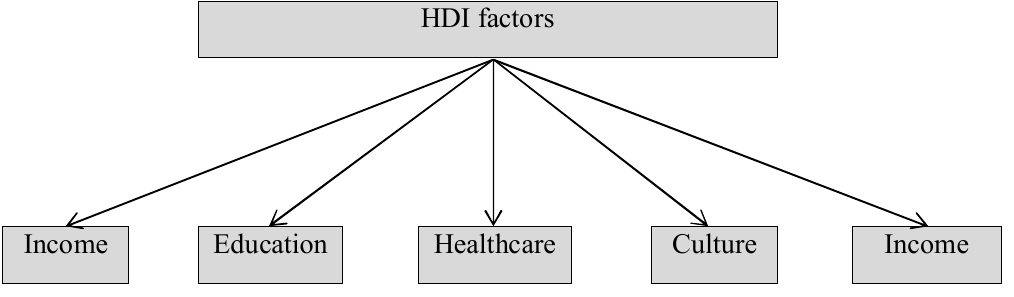
Fig. 1. The hierarchy of the proposed study